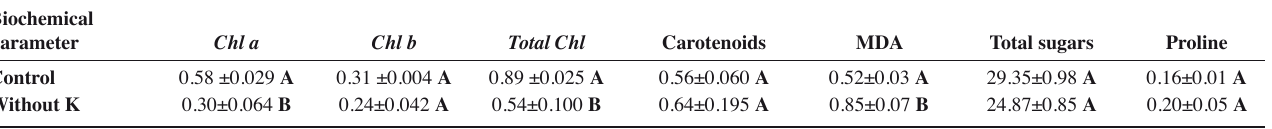
Tab. 3: Contents of photosynthetic pigments (mg g -1 leaf fw), malondialdehyde (MDA) ( μ mol mL -1 ), total sugars (μg mg -1 leaf fw), and proline (μg g -1 ) in the leaves of tree tomato plants during vegetative growth. Means ± standard error (n = 3 per treatment) are presented. Control (without deficiencies) and plants grown without K (potassium deficiency). Different letters indicate significant statistical differences with a P value <0.05 (the Tukey’s test).